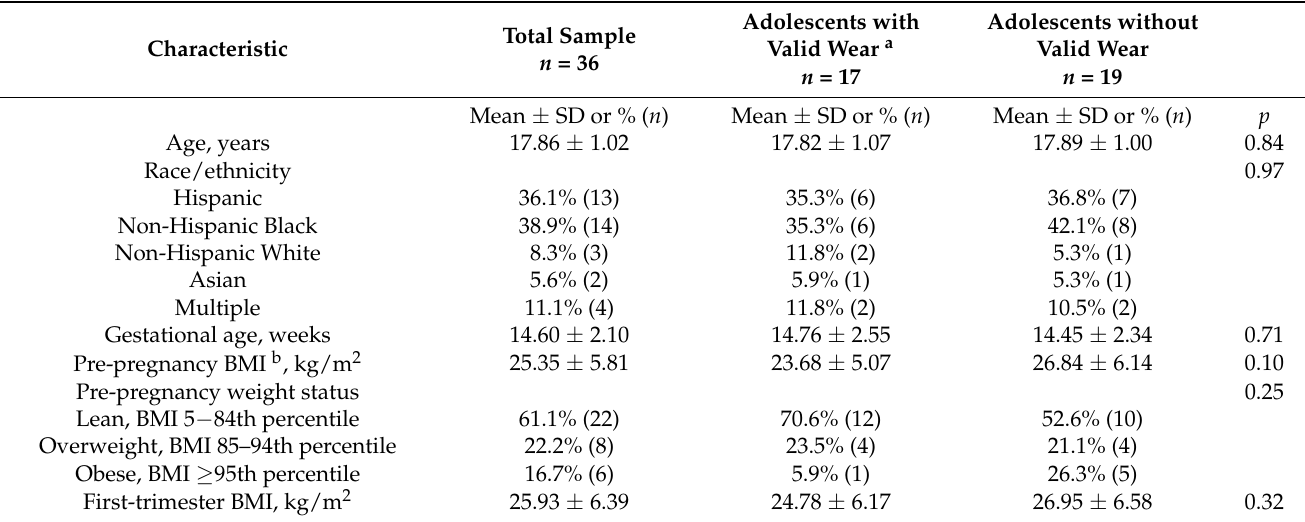
Table 1. Descriptive information for study